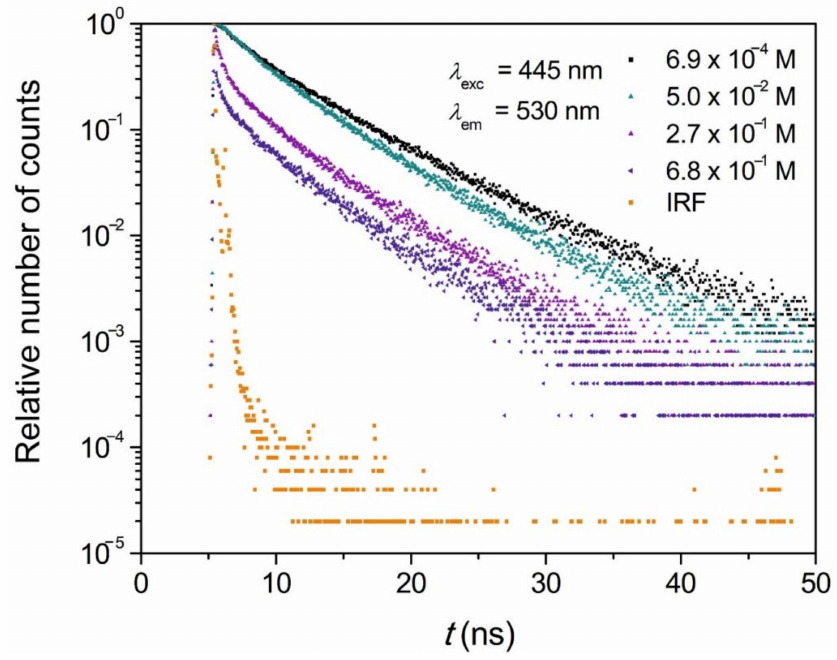
Figure 3. The fluorescence intensity decays of FMN in PVA films measured over a wide concentration range from 6.9 × 10 − 4 M to 6.8 × 10 − 1 M (for four concentrations) at room temperature ( λ exc = 445 nm, λ em = 530 nm). The instrument response function (IRF, orange) is shown for